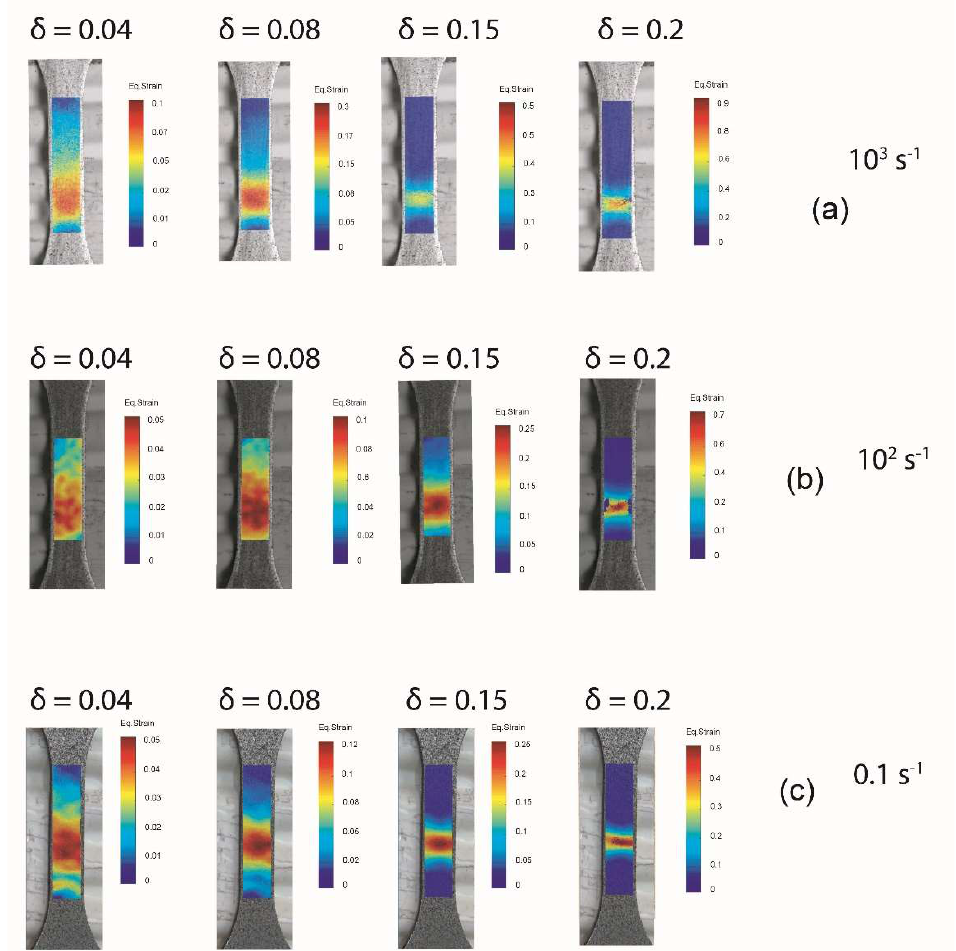
Figure 5. Equivalent strains in smooth specimens under tension with strain rates of ( a ) 10 3 , ( b ) 10 2 , and ( c ) 0.1 s -1 at the temperature of 673 K.